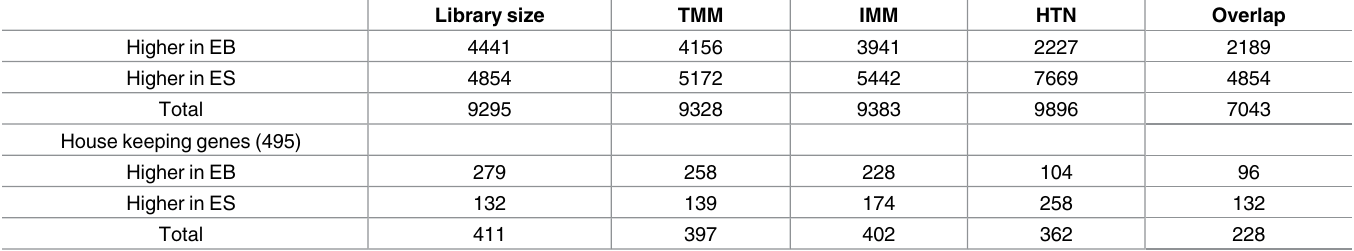
Table 2. The number of DE genes between embryoid bodies (EB) and embryonic stem cells (ES) at a cutoff p-value < 10 − 4 for different normaliza- tion methods. Library